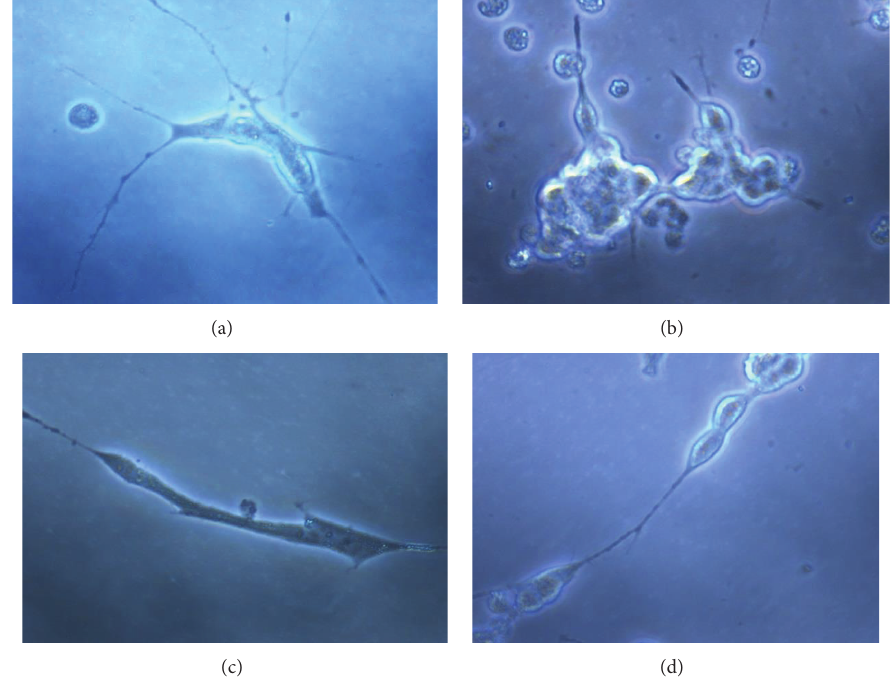
Figure 4: Effect of treatments on morphology of differentiated SH-SY5Y cells. (a) Control, (b) glutamate (20 mM), (c) glutamate + insulin (0.1 𝜇 M), and (d) glutamate + insulin (1 𝜇